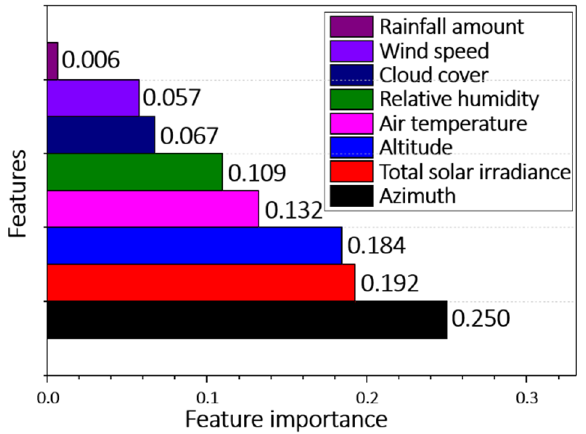
Figure 6. Graded importance of features in the rail-temperature. prediction, obtained by XGBoost.